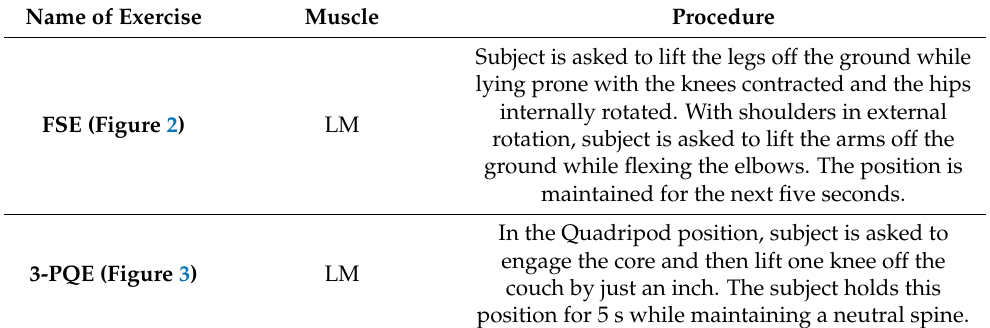
Figure 1. Schematic diagram for electrode placement for the lumbar multifidus muscle.